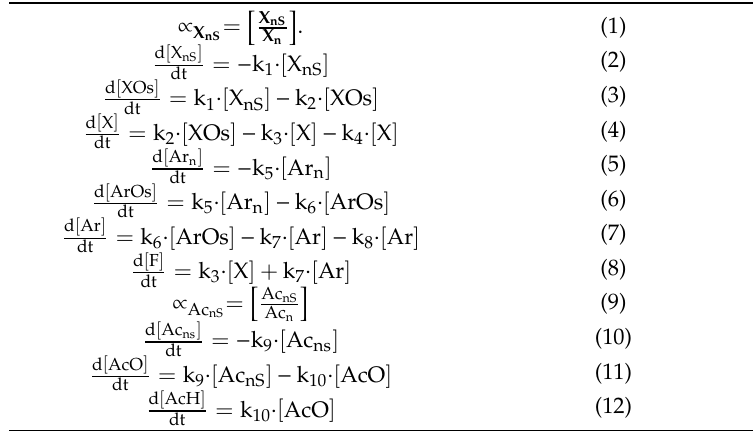
Table 5. Equations employed for kinetic modeling of the reactions involving hemicellulosic polysaccharides and acetyl groups in wood.